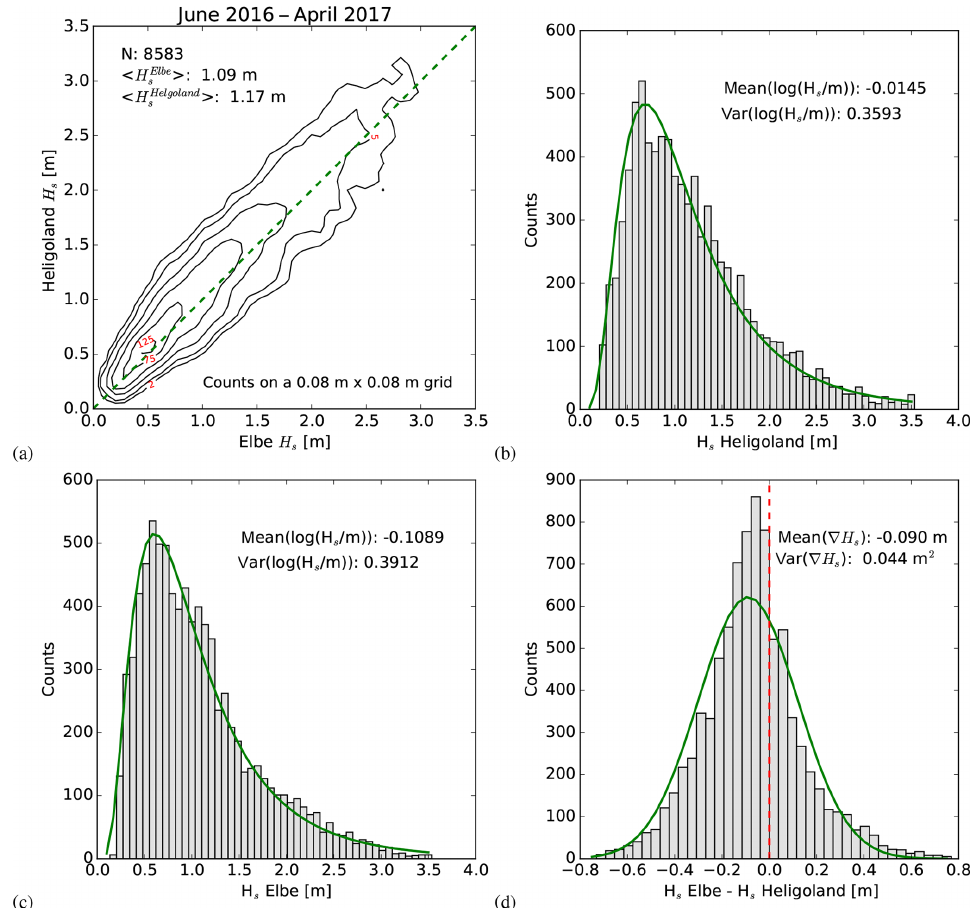
Figure 4. Background statistics used for the Monte Carlo Simulations. (a) 2-D histogram of the joint distribution for the Elbe and Heligoland buoys derived from the period June 2016–April 2017 with diagonal given as a dashed green line and the black isolines referring to probability density. (b) 1-D histogram for the Heligoland buoy wave heights with log-normal probability density function (pdf) superimposed in green. (c) The same as (b) for the Elbe buoy. (d) Histogram of the difference between the Elbe and Heligoland wave height with Gaussian pdf superimposed in green, and the dashed red line indicating the zero